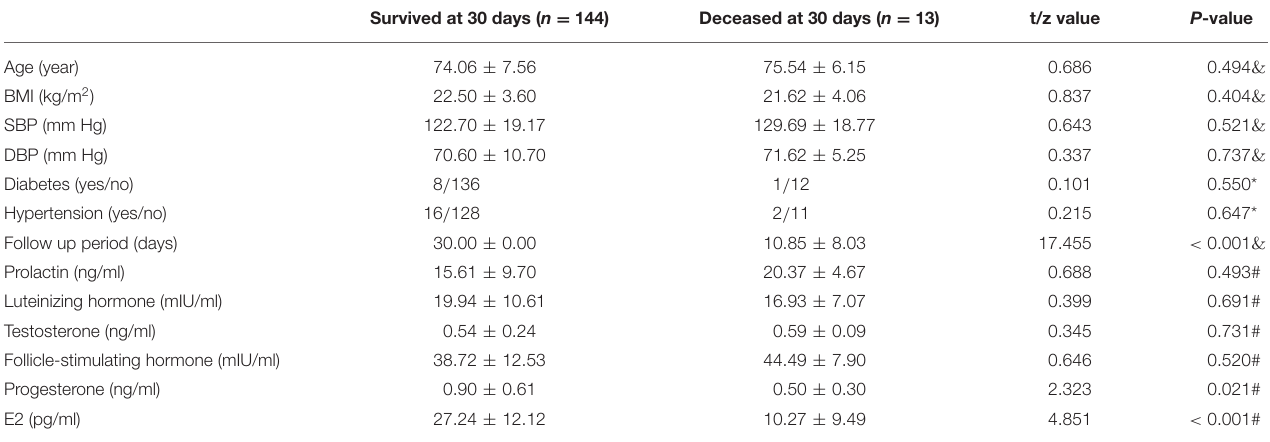
TABLE 1 | Baseline demographic and disease characteristics of subjects.